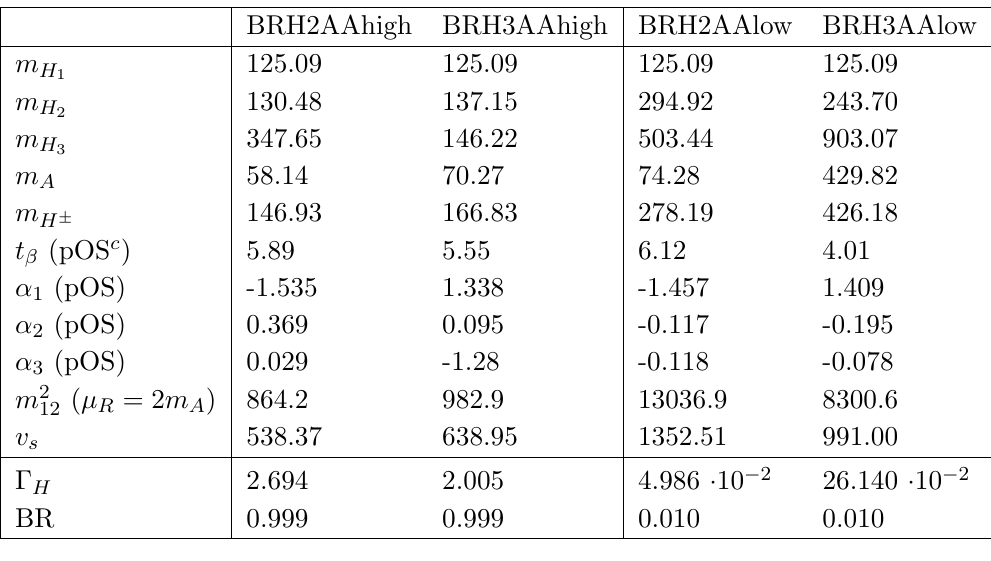
Table 8 . Input parameters for the N2HDM benchmarks used in the numerical analysis of the decay process H ! AA . All masses and v S are given in GeV. The LO total width (also given in GeV) 2 = 3 and individual branching fractions in the last two rows correspond to the Higgs state and decay each benchmark is named after, and have been generated with N2HDECAY .